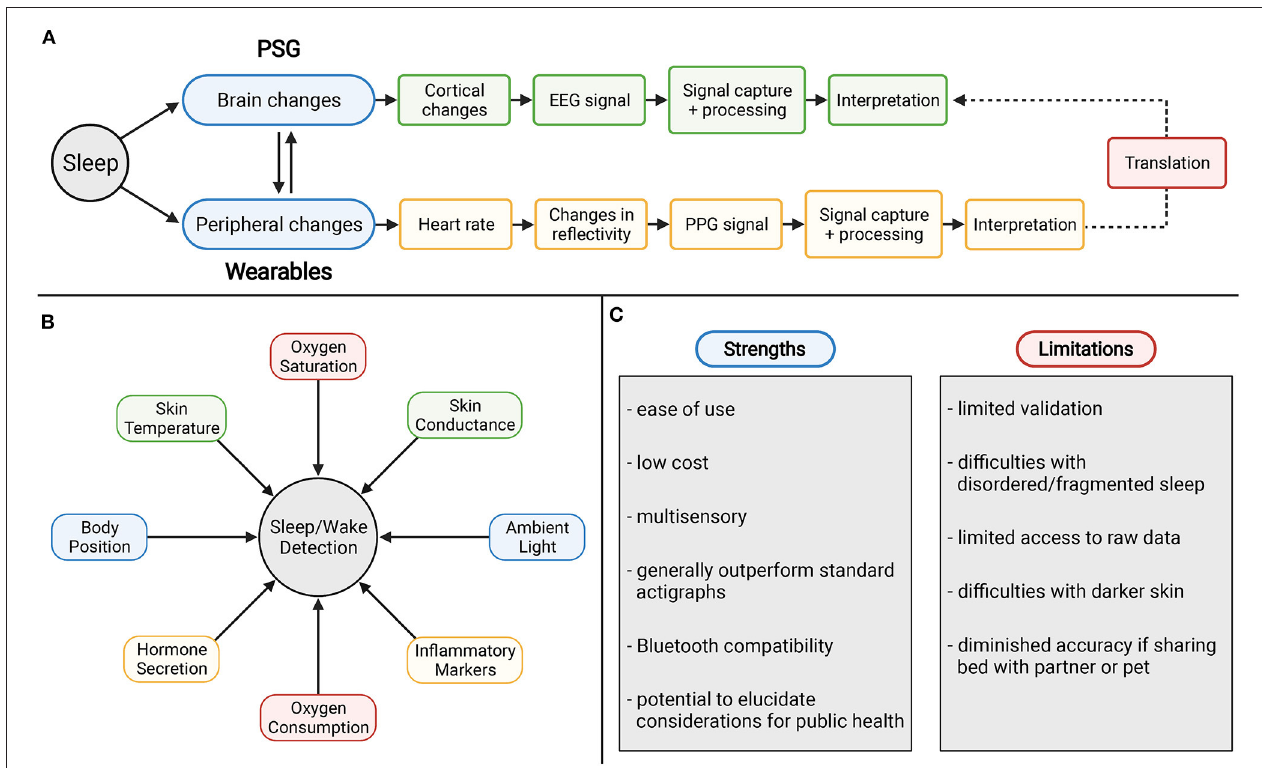
FIGURE 8 | (A) Ceiling effect in accuracy with wearable devices using PPG technology. (B) Potential novel metrics for sleep and wake measurement. (C) Strengths and weaknesses of consumer sleep